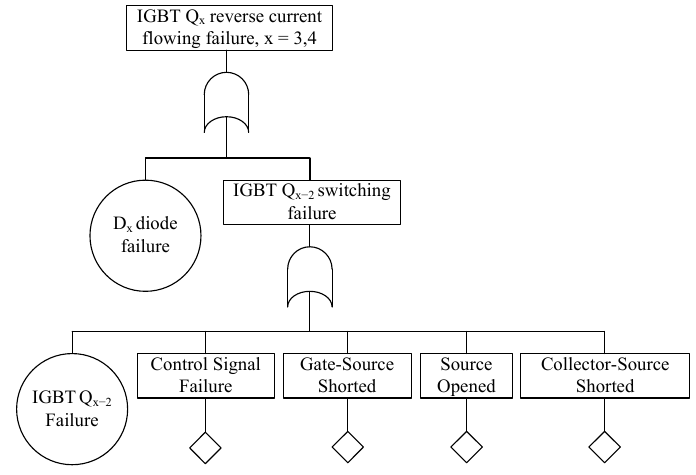
Figure 16. Sub fault tree for IGBT Q x reverse current flowing failure, x = 3,4.